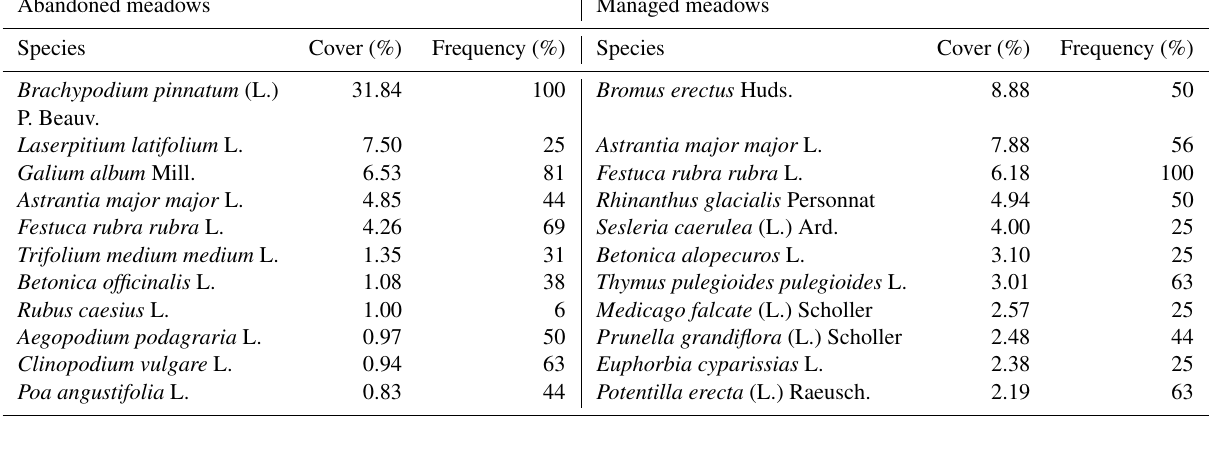
Table 1. Plant species cover and frequency in abandoned and managed meadows. Species are ordered by descending cover. Values are means. Abandoned meadows Managed meadows Species Cover (%) Brachypodium pinnatum (L.)